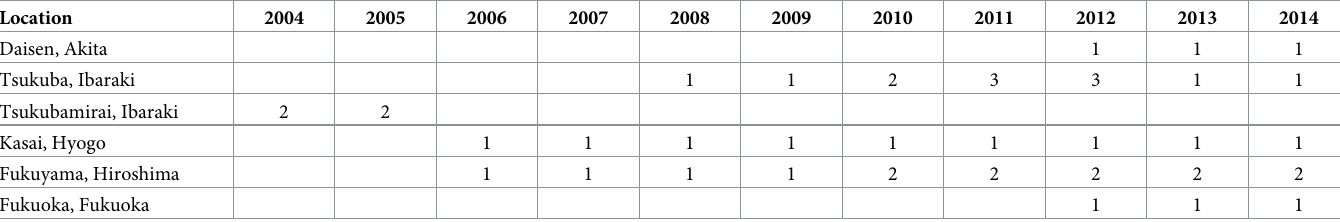
Table 2. Location, year, and number of replications of field experiments to record heading date.